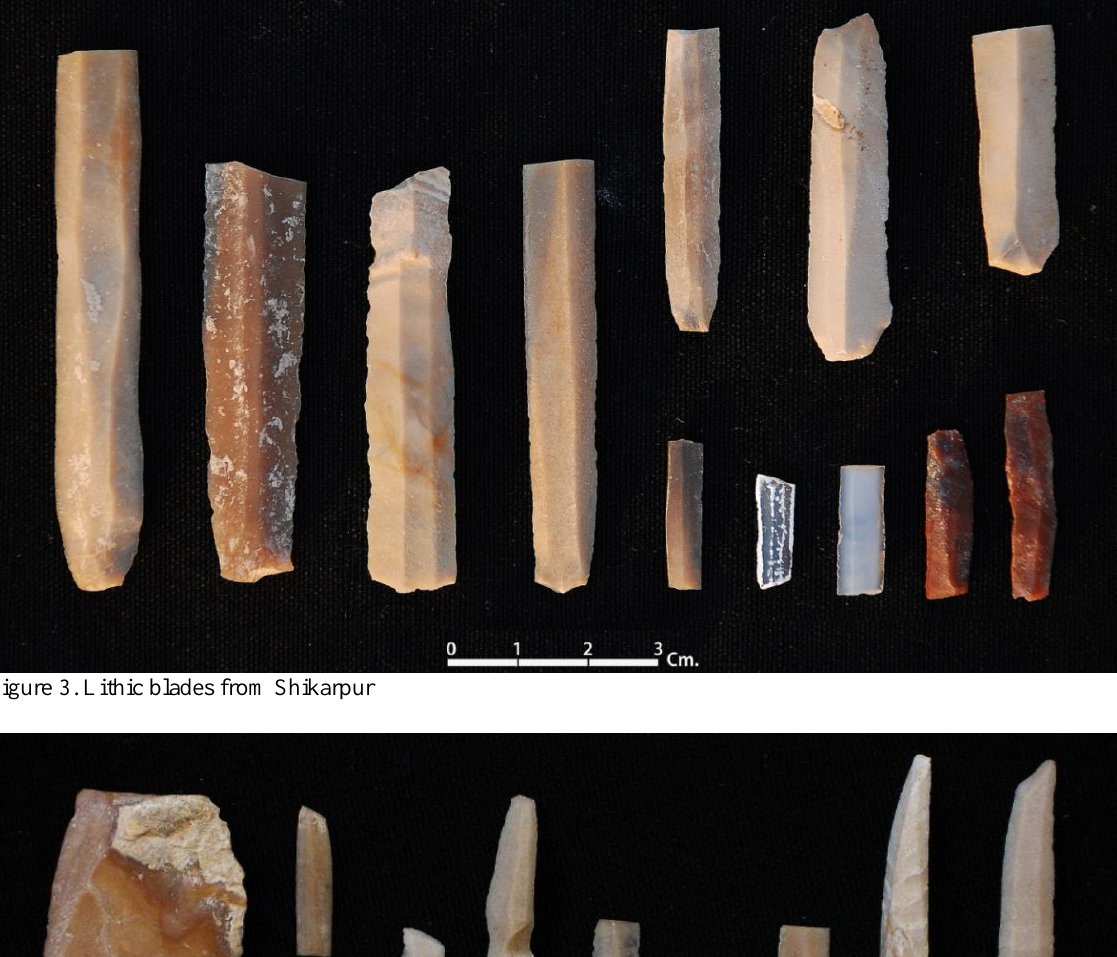
Figure 3. Lithic blades from Shikarpur